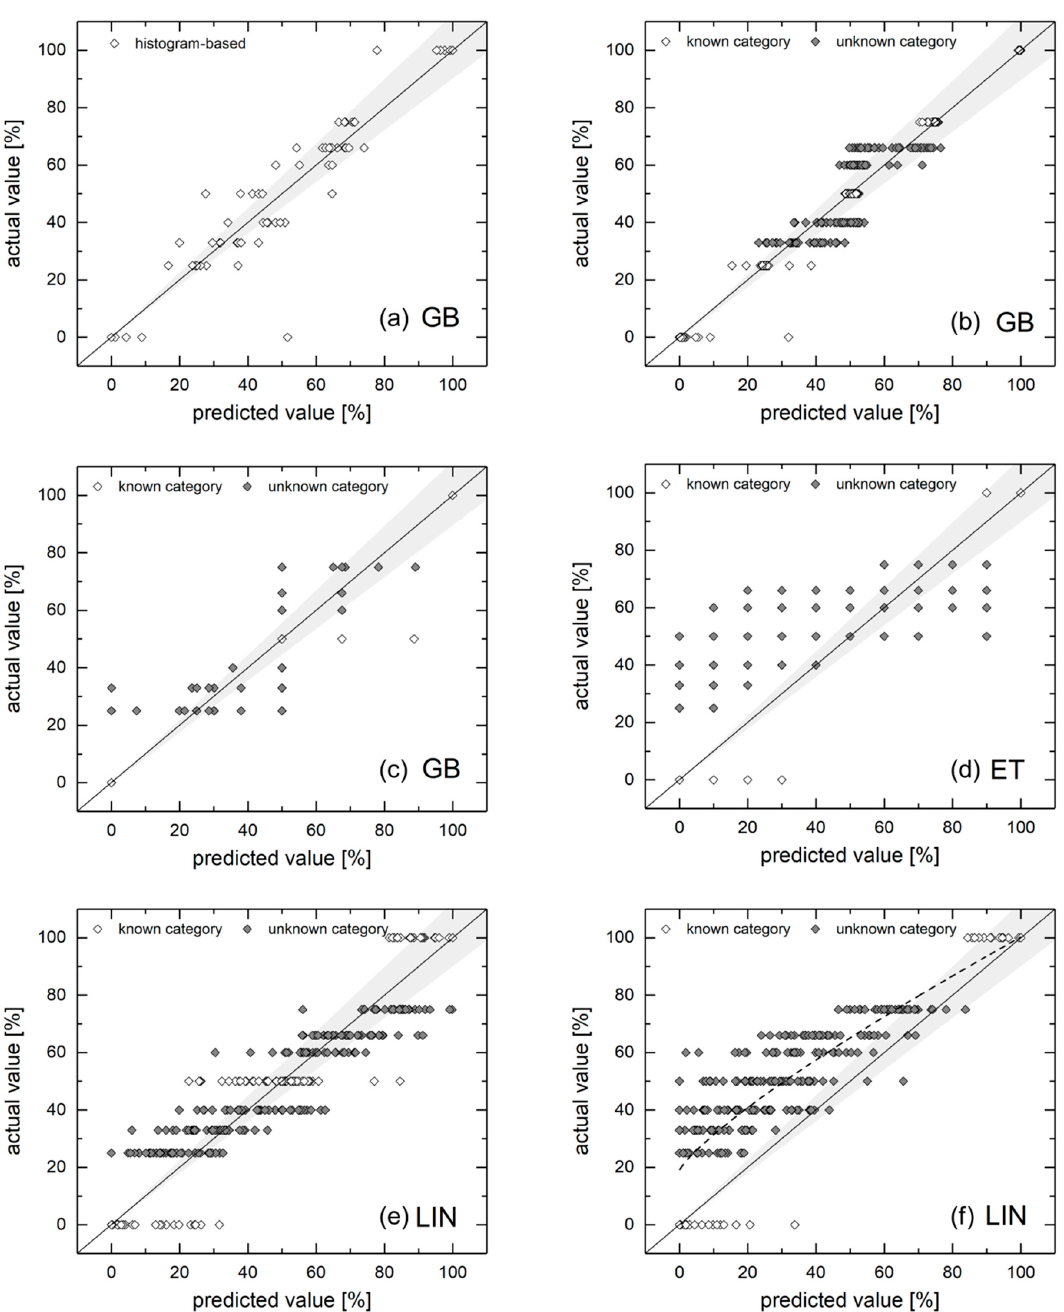
Figure 9. Results for the fuel quality obtained from different training strategies. ( a ): reference case with all classes used for training; ( b ): training using 0, 25, 50, 75 and 100%; ( c ): 0, 50 and 100% class; ( d ): 0 and 100%; ( e ) and ( f ): as (b) and (d), but with linear model. Grey shade indicates the range of ± 10% error.